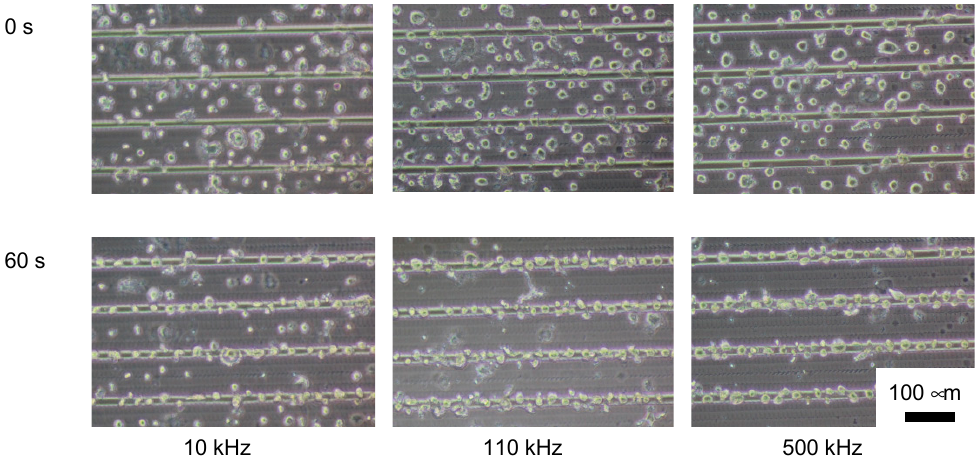
Figure 6. Dielectrophoresis of MEF cells using a parallel line-electrode array before (0 s) and after (60 s) dielectrophoresis.